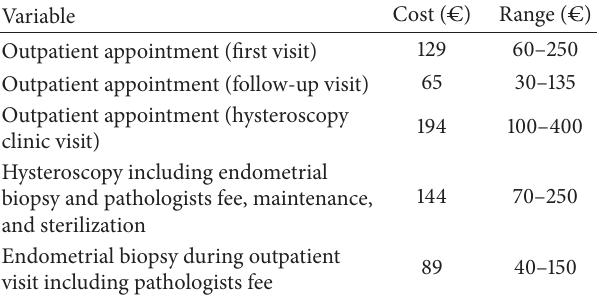
Table 1: Model input: direct medical